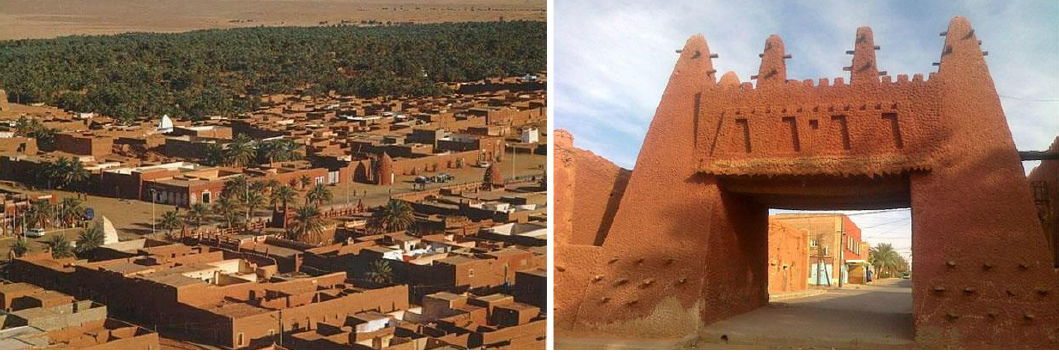
Figure 4 The colonial architectural character of the city in general and